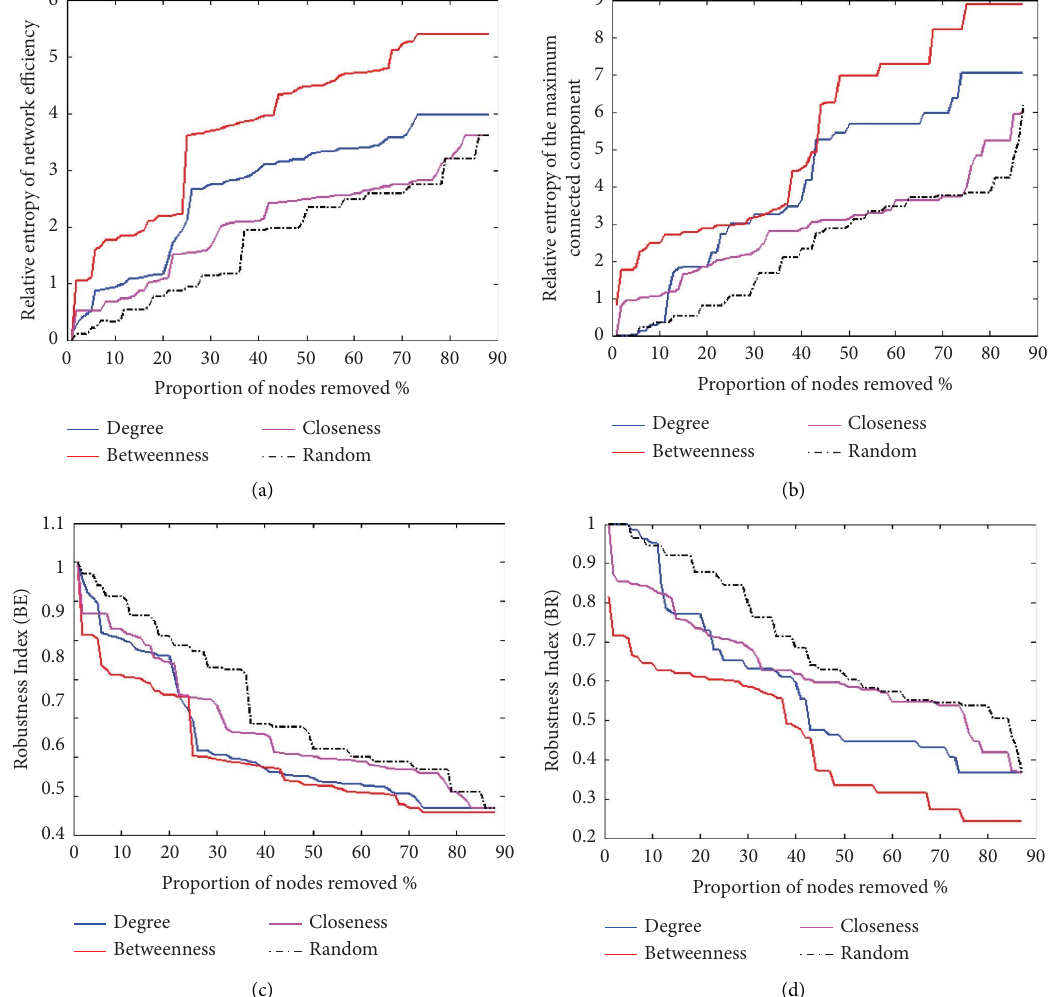
Figure 16: Te robustness of ACMN is based on relative entropy. (a) Relative entropy of network efciency. (b) Relative entropy of the maximum connected component. (c) Te BE of a multilayer network. (d) Te BR of a multilayer network.